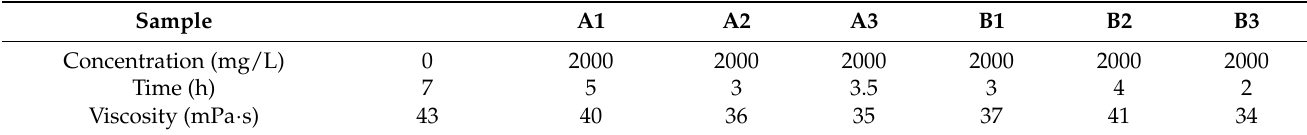
Table 3. Effects of cosolvents on solubility of the polymer.